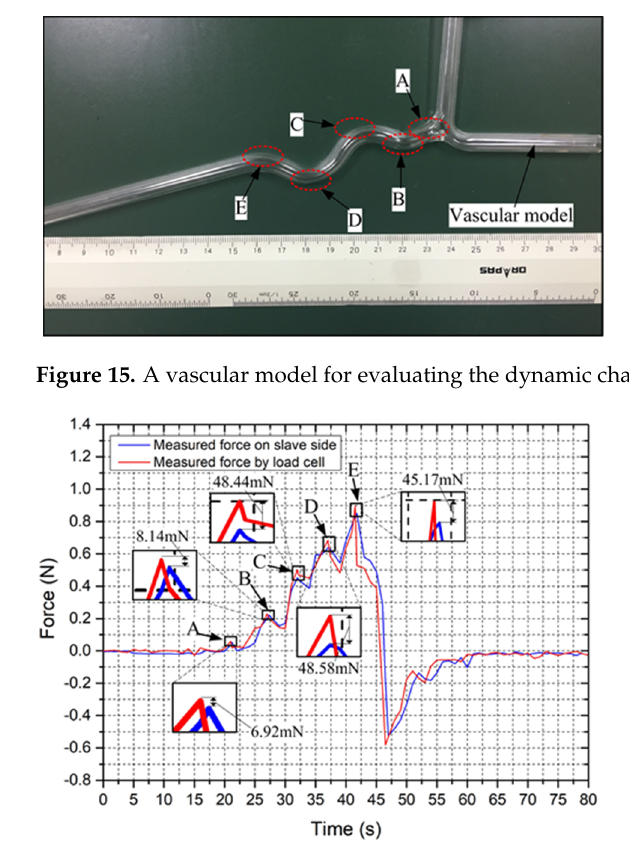
Figure 16. The experimental results for the dynamic characteristic.